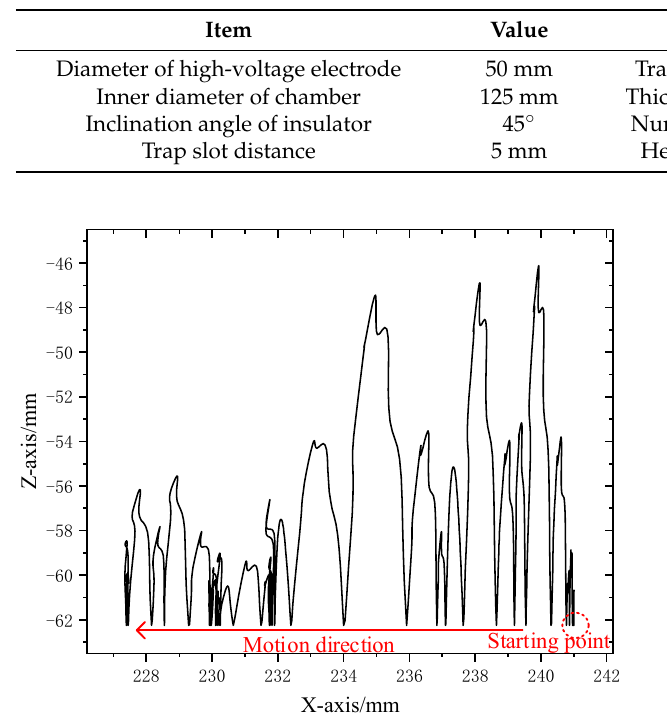
Figure 5. Particle trajectory.